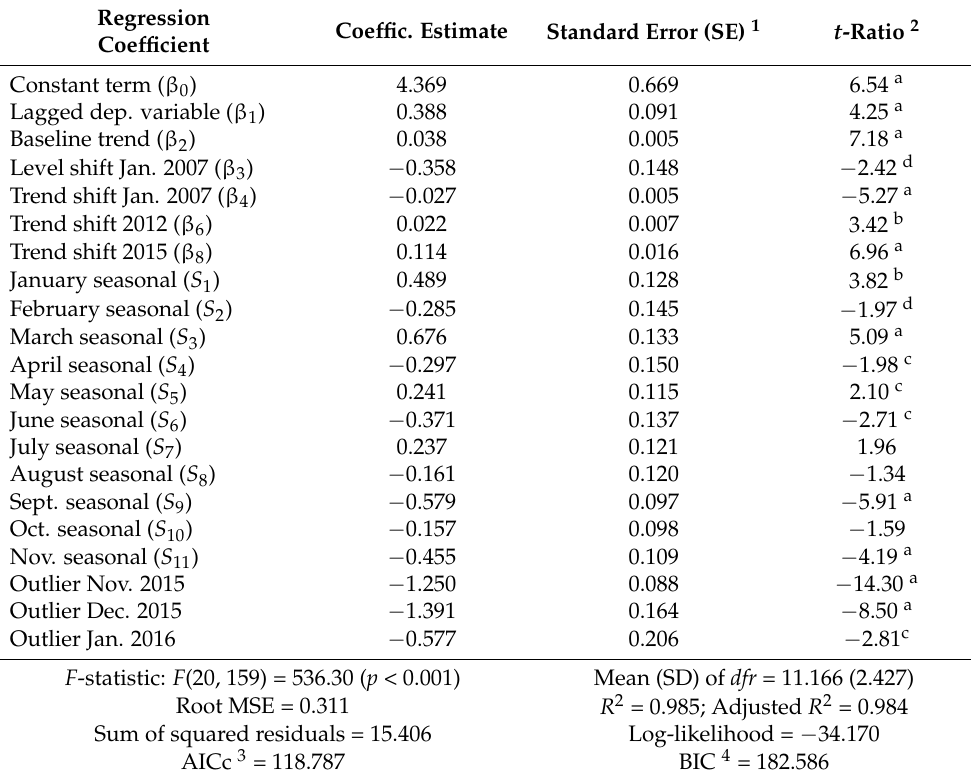
Table 1. OLS regression estimates for monthly drug-related fatality rate ( dfr ).